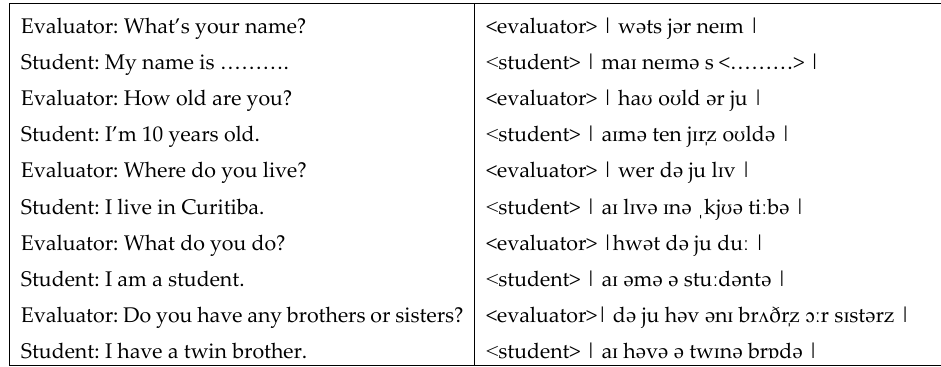
Table 6. Transcript 6.